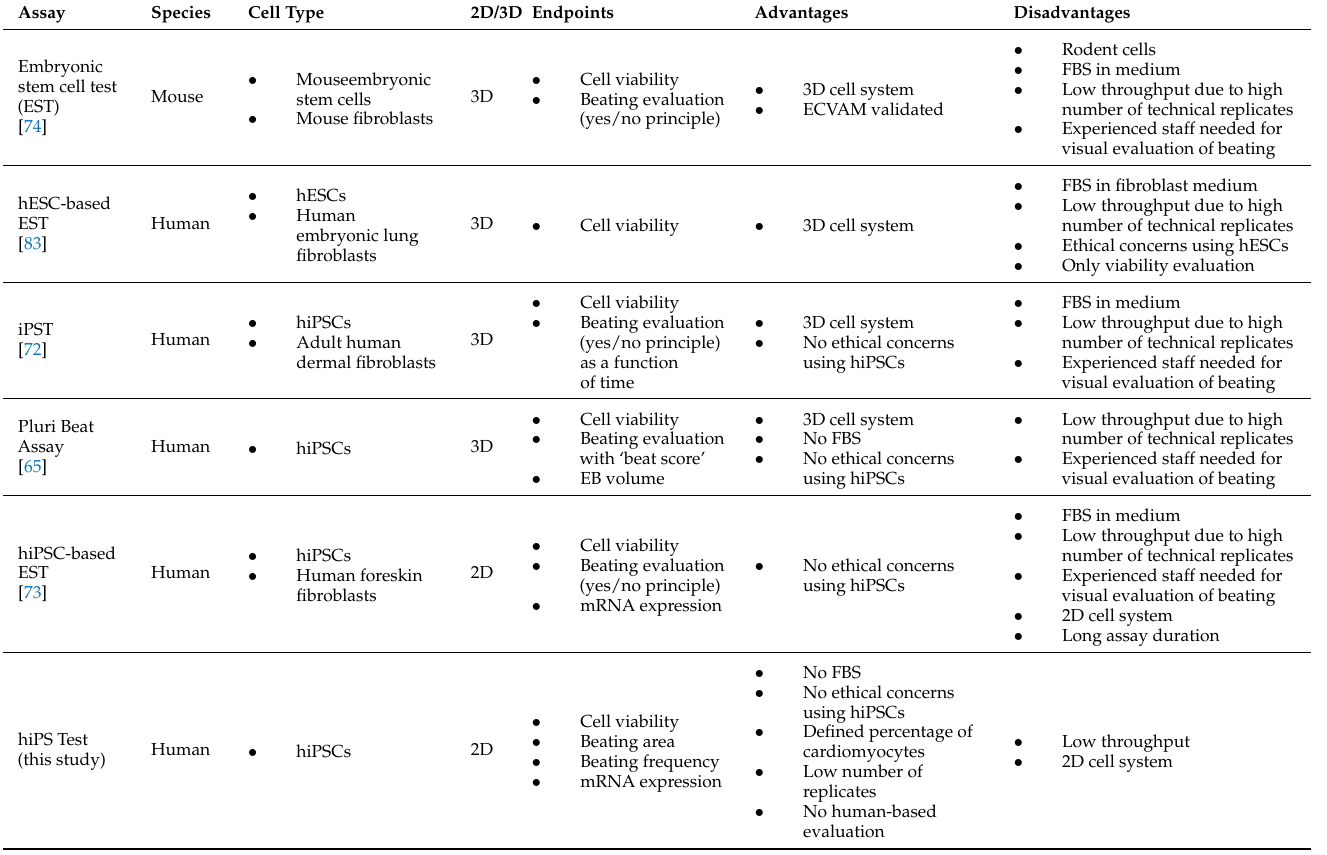
Table 4. Published in vitro embryotoxicity assays based on stem cell differentiation into